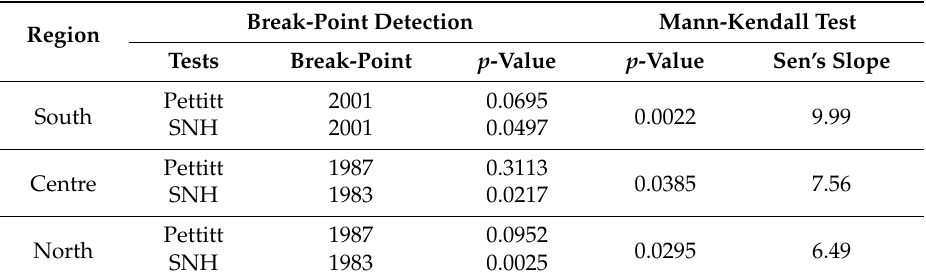
Table 3. Results of break-point detection and Mann-Kendall test on observed rainfall. Region